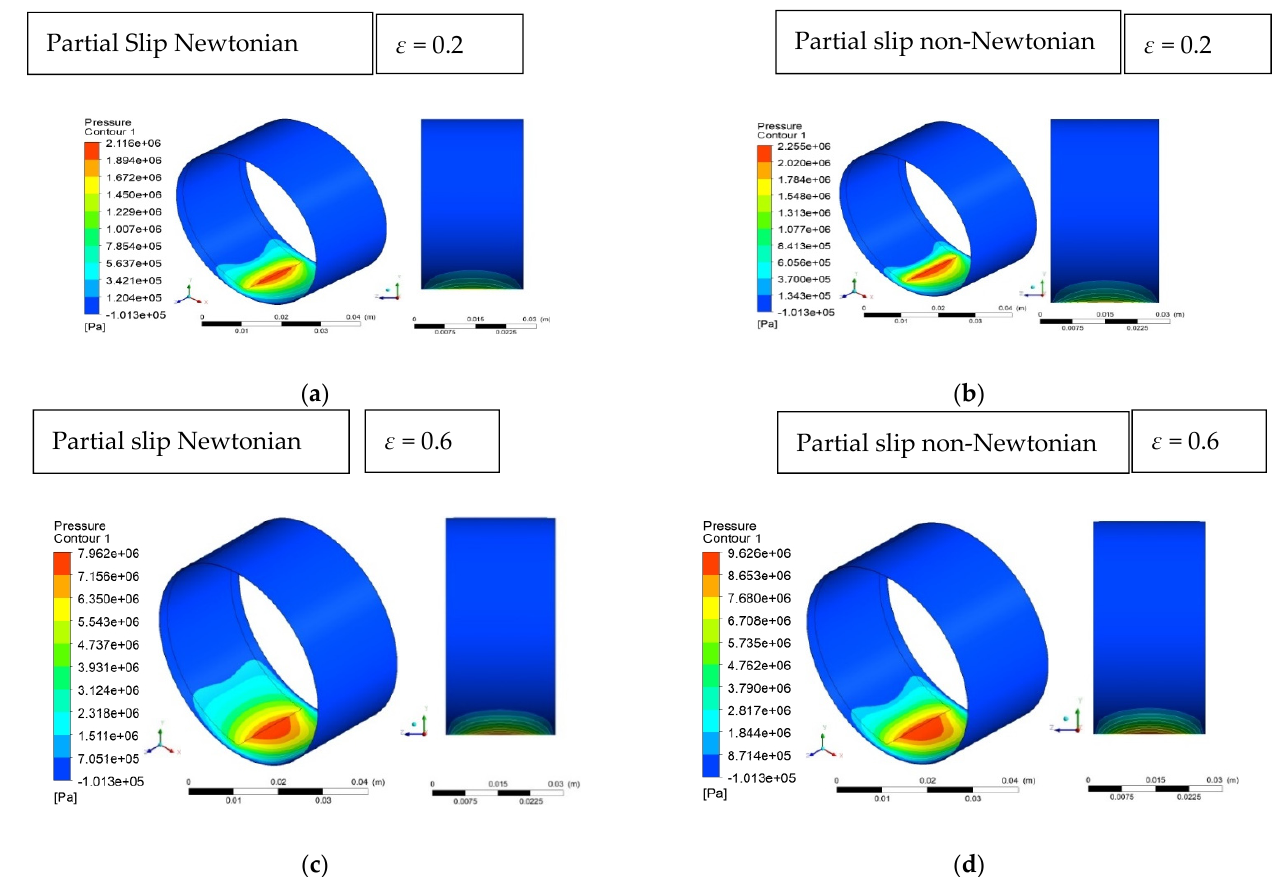
Figure 9. Pressure distribution for partial slip bearing for case: ( a ) Newtonian, ε = 0.2; ( b ) non-Newtonian, ε = 0.2; ( c ) Newtonian, ε = 0.6; ( d ) non-Newtonian, ε = 0.6.